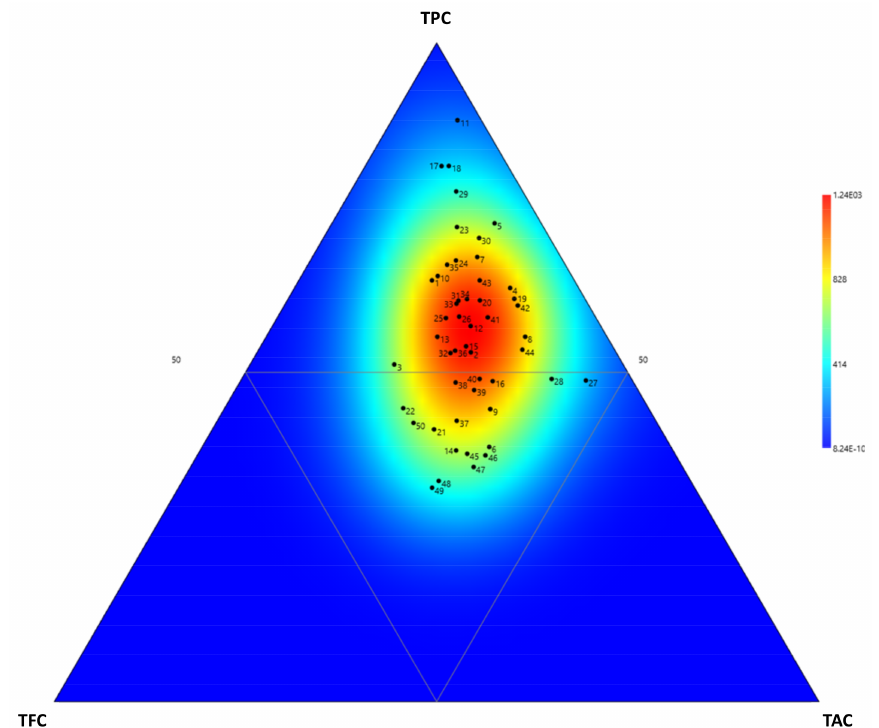
Figure 2. Ternary plot showing the relative TPC, TFC, and TAC within the 50 Fabaceae populations from various floristic regions from